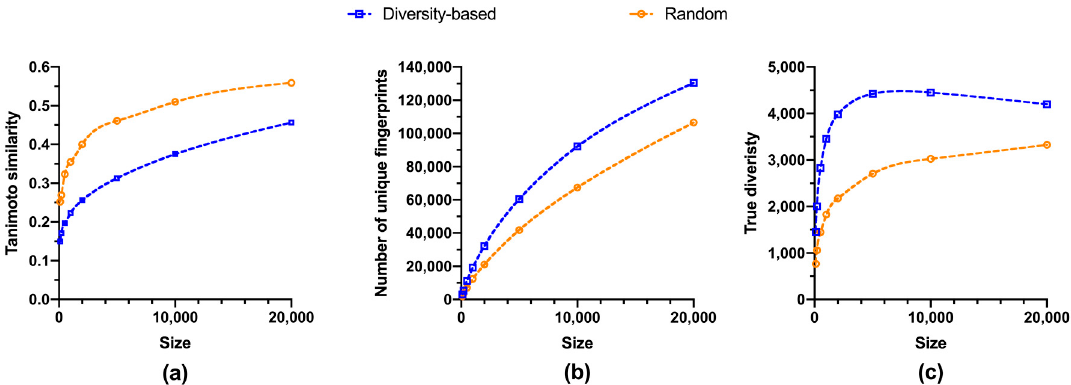
Figure 3. Structural diversity vs size of fluorinated fragment libraries, with the former measured by: ( a ) Average of the similarity of each compound to its closest neighbor; ( b ) total number of unique fingerprints (richness); ( c ) true diversity calculated by equation 1. Dash curves are generated from cubic spline fitting. Metrics for random selections are average values of triplicates (Table S2).